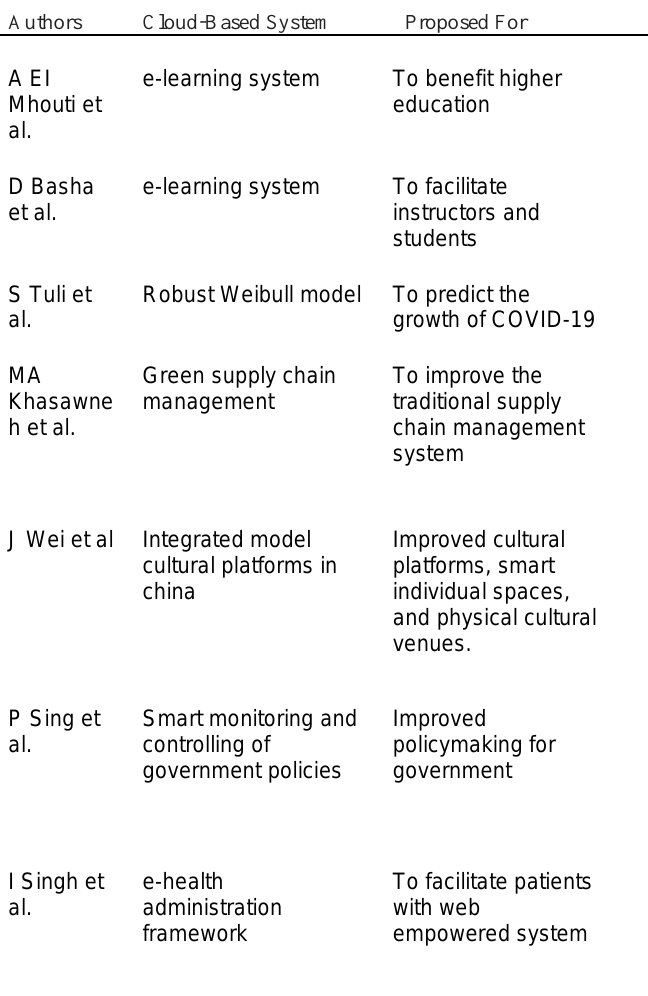
Table 2. Cloud Computing Based Models with their Impact on